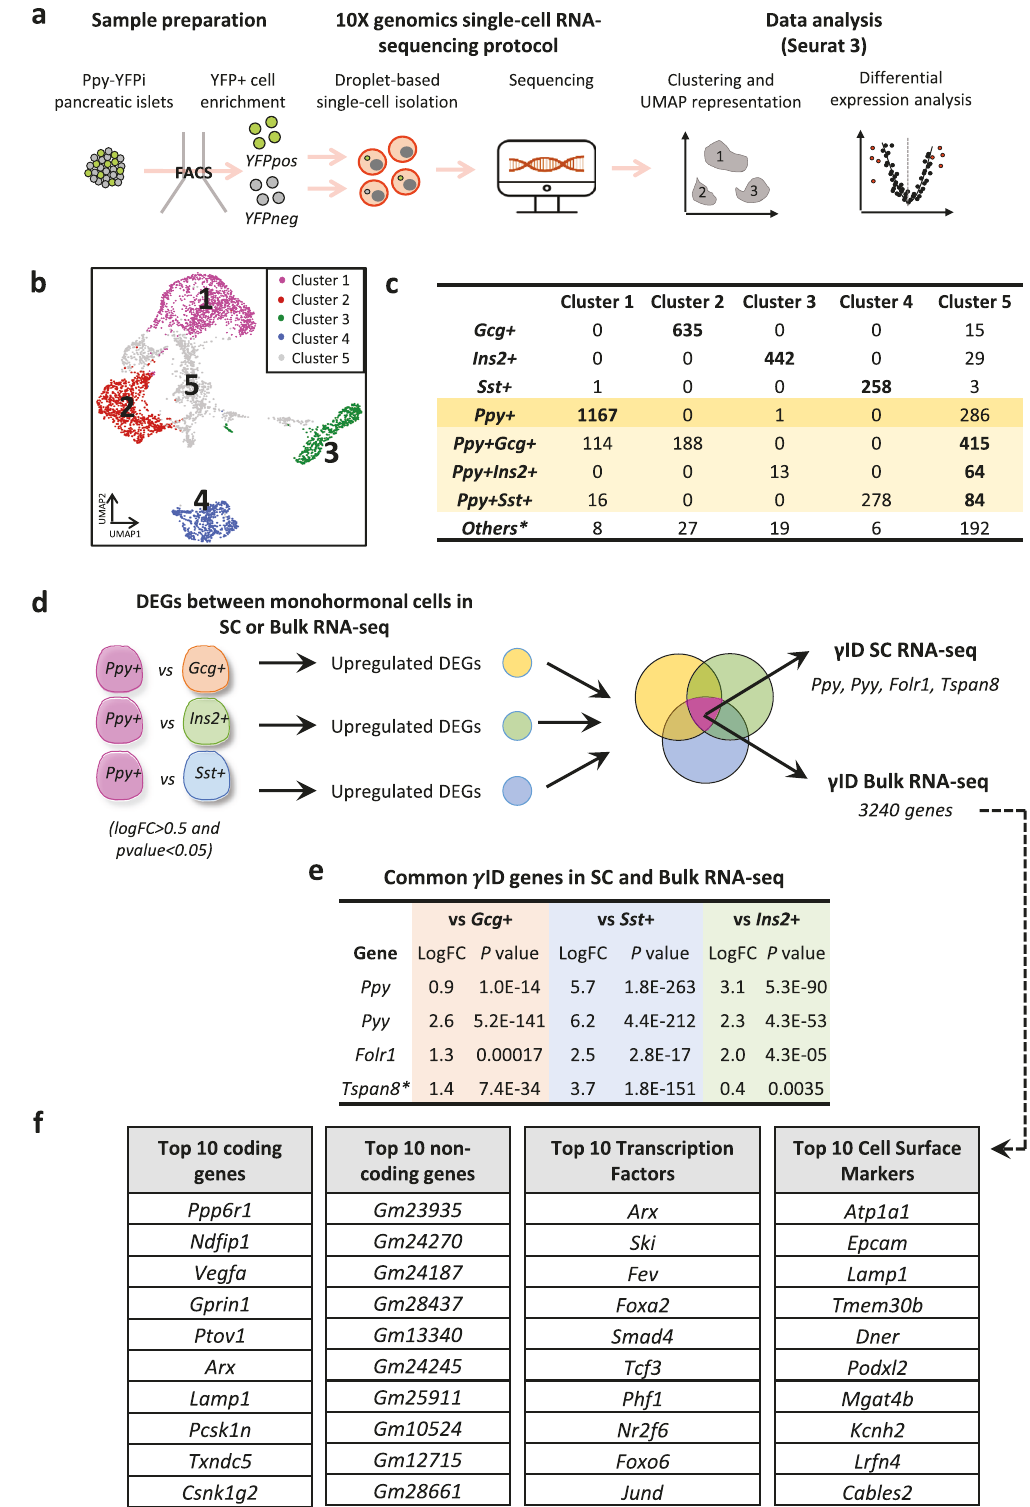
transcriptional pro fi le. After doublet removal, we de fi ned fi ve populations based on unsupervised clustering (Cluster 1 – 5; Fig. 4b). Each endocrine cell-type cluster was identi fi ed using hormone expression: Gcg + (Cluster 2), Ins2 + (Cluster 3), Ppy + (Cluster 1), Sst + (Cluster 4) and Ppy + bihormonal (Cluster 5) (Fig. 4b, c; Supplementary Fig. 7; see methods). Cells surpassing the mathematically-de fi ned threshold of expression of two